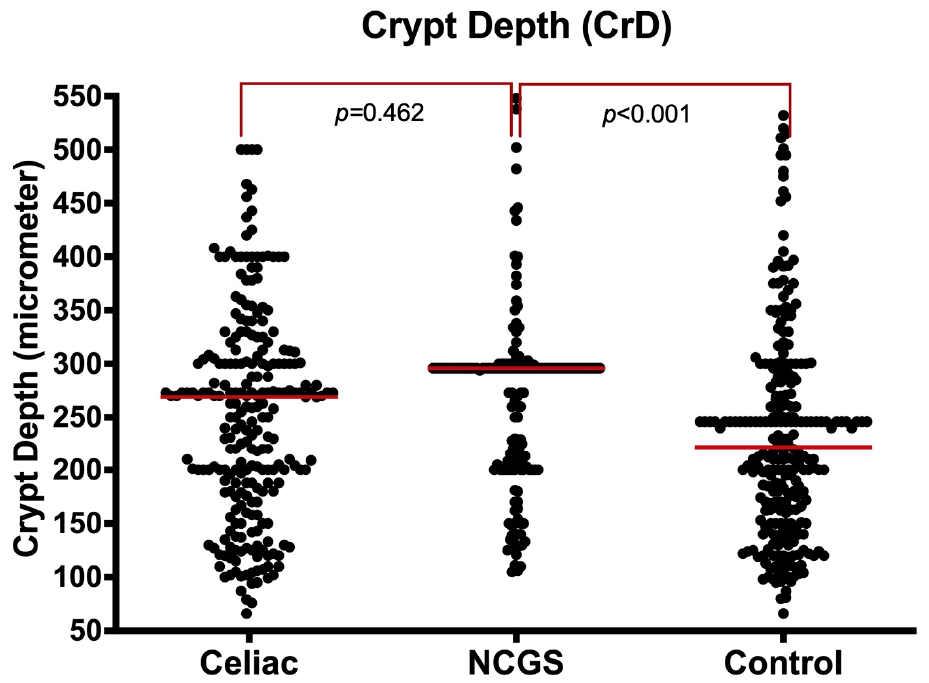
Figure 2. Crypt depth ( μ m) in NCGS compared to CeD and controls, entire cohort.